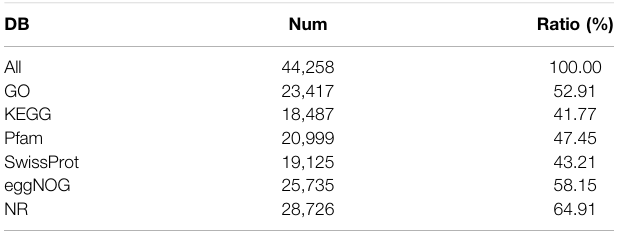
TABLE 3 | Summary of function annotation of SD.